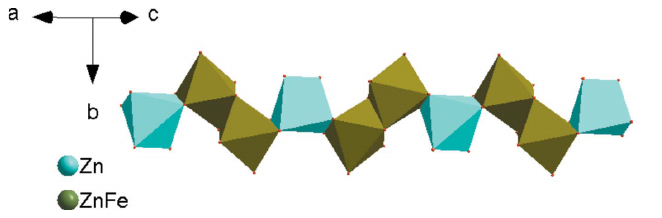
Figure 4 Polyhedral representation of Ag 2 Zn 2 Fe(VO 4 ) 3 showing the channels running parallel to the [001]